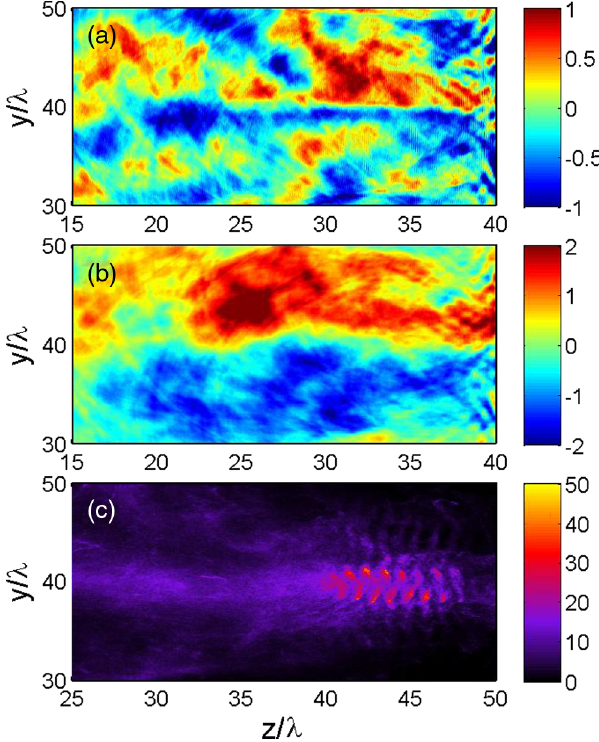
FIG. 4. (a) The self-generated quasistatic electric field E s y normalized by m e ω c=e , (b) the self-generated quasistatic mag- netic field B s x normalized by m e ω c=e , and (c) the electron energy density U normalized by n c m e c 2 in the channel at t ¼ 75 T 0 . The laser and plasma parameters are the same as those of Fig.